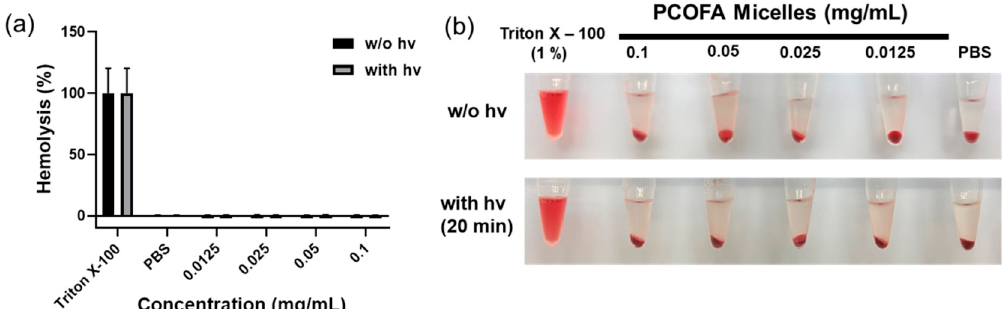
Figure 6. ( a ) Quantification and ( b ) macroscopic images of hemolysis of sheep erythrocytes (2%) treated with Triton X-100 (1%, positive control), PBS (negative control) and PCOFA micelles at different concentrations without or with 410 nm light irradiation (410 nm, 28 mW/cm 2 , 20 min).